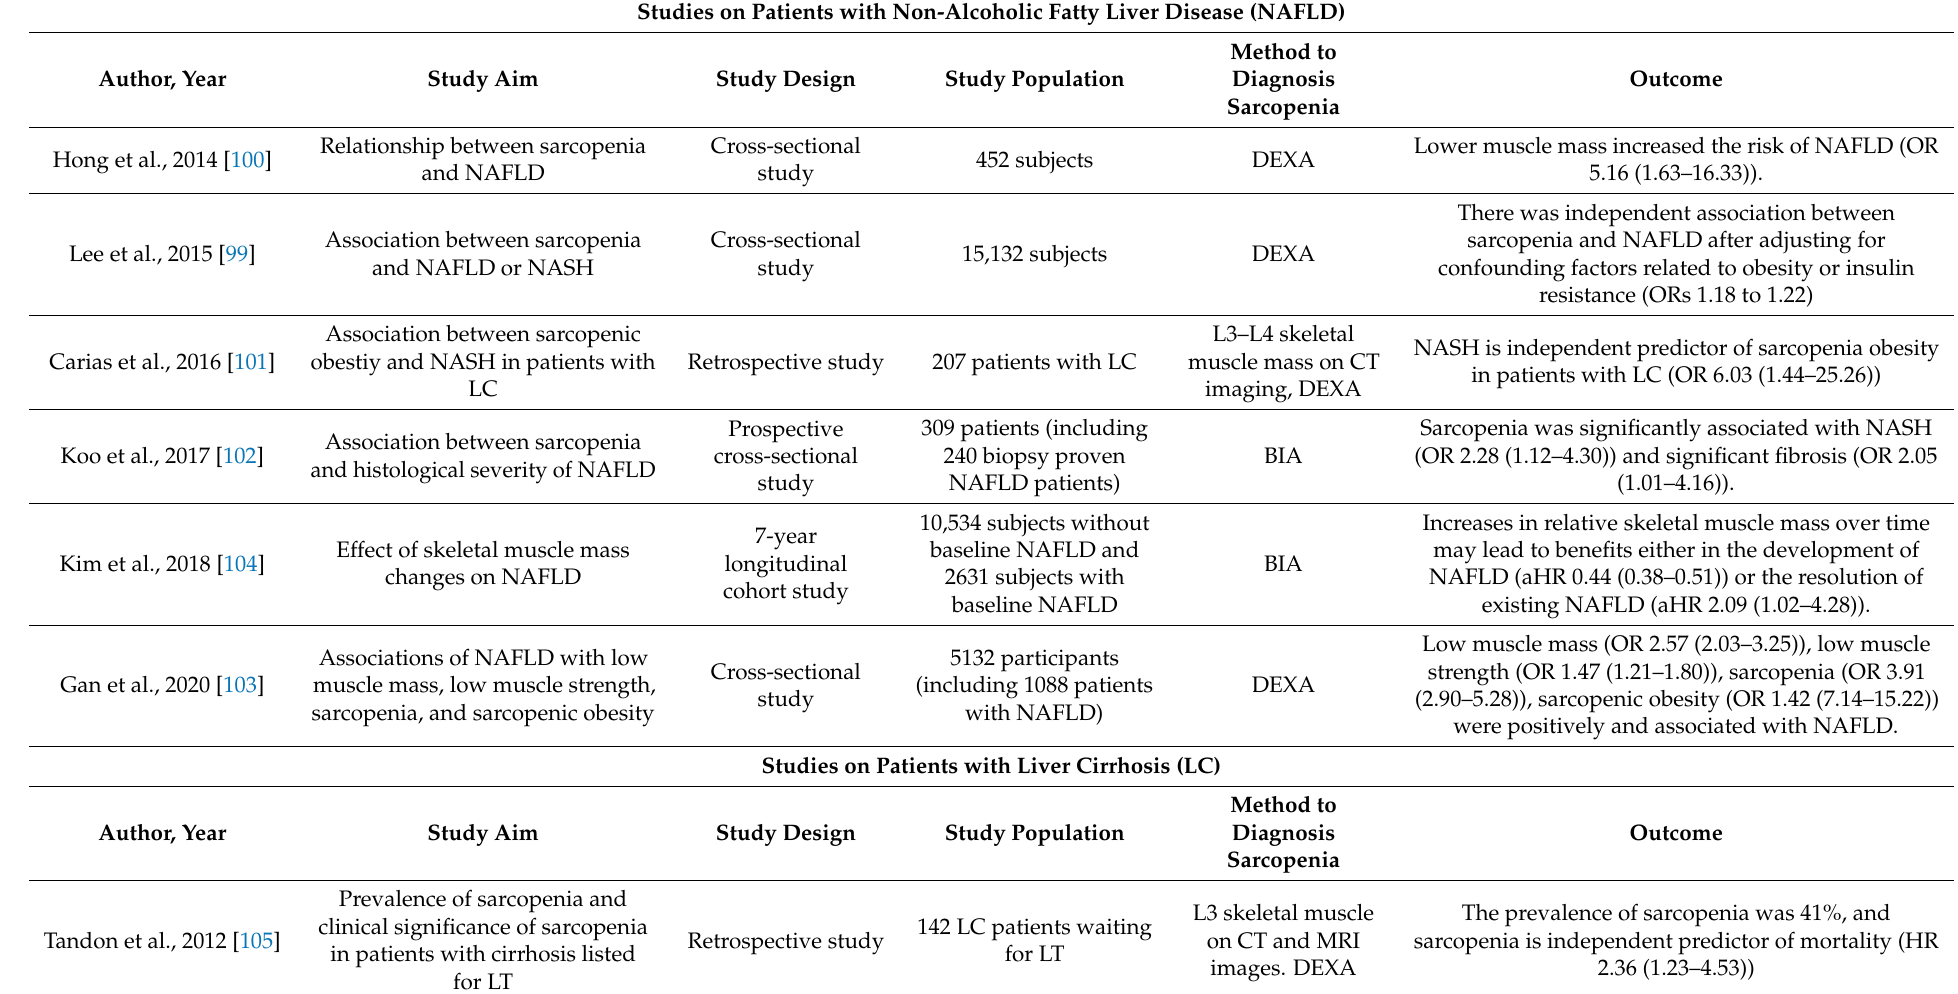
Table 2. Representative clinical studies for sarcopenia in chronic liver